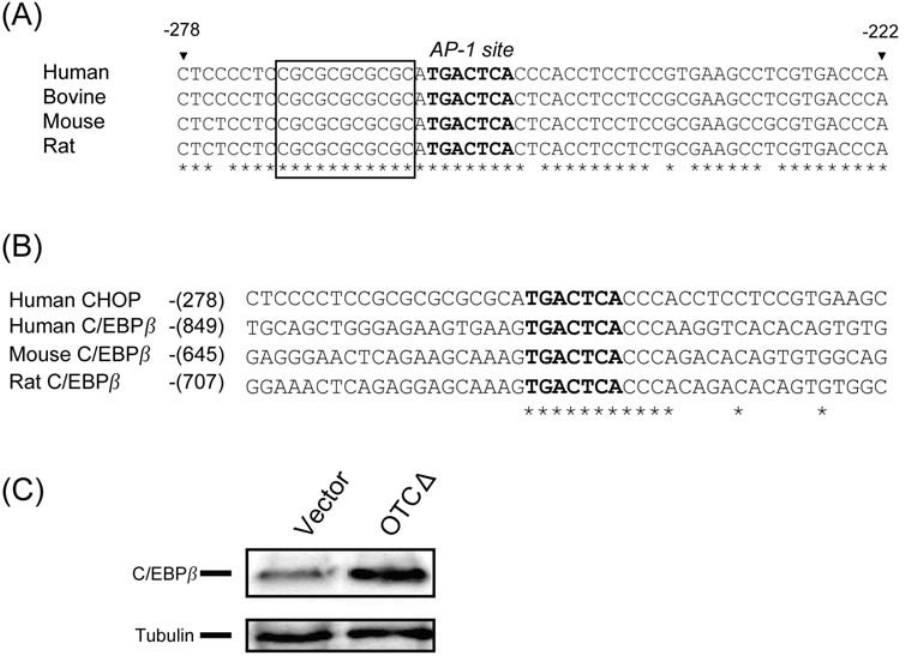
Figure 2. Chopand c/ebp b promoters contain AP-1 sites and are inducible by mtUPR. (A) Nucleotide sequence alignment of the mammalian chop promoters ( 2 278 to 2 222) from human, bovine, mouse and rat. Bold letters show the highly conserved bases of the AP-1 site and the asterisks show the highly conserved sequence surrounding the AP-1 site in chop promoters. The position of the putative novel element of N 30 [18] is shown in the box. (B): Nucleotide sequences of mammalian c/ebp b promoter region around AP-1 site (Human, Mouse, and Rat) is compared with the chop promoter sequence ( 2 278 to 2 233). The numbers refer to the distance from transcription initiation site of human chop or human, mouse, and Rat c/ ebp b . The asterisks indicate the conserved nucleotides around the AP-1 site. (C): C/EBP b expression in response to mtUPR. Extracts from cells transfected with vector or OTC D were subjected to western blotting and probed with antibodies against C/EBP b and tubulin as control and show that C/EBP b , like CHOP is induced by expression of OTC D